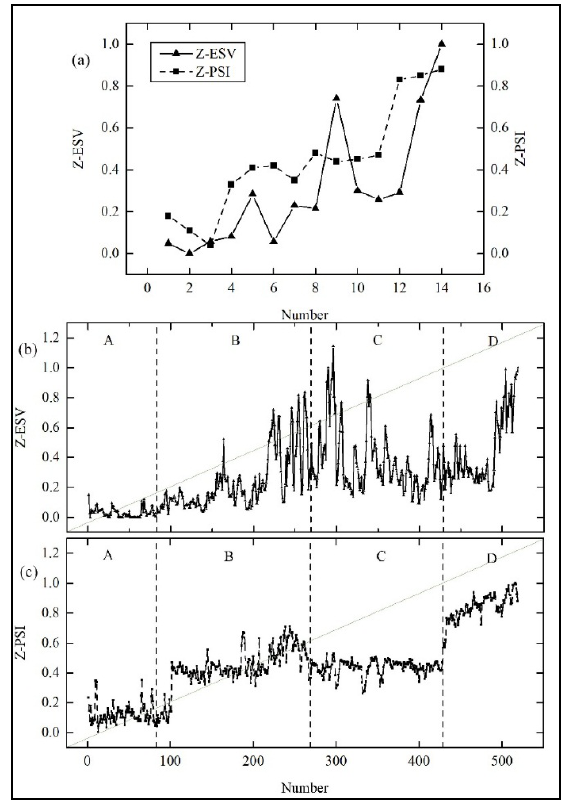
Figure 4. The trend of Z-ESV and Z-PSI: (a) was the trend of Z-PSI and Z-ESV based on the 14 BEUs corresponding to 14 measured sites; (b) and (c) was trend of Z-ESV and Z-PSI based on 520 BEUs, respectively; A, B C and D was the four measurement sections.